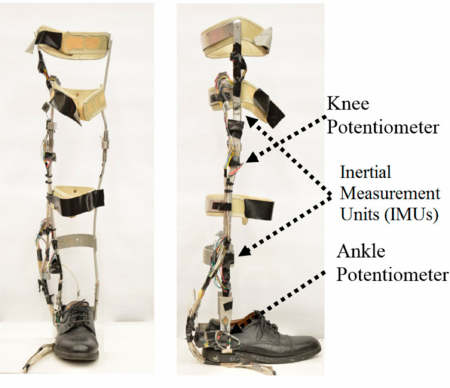
Figure 1. Sensors installed on the orthosis